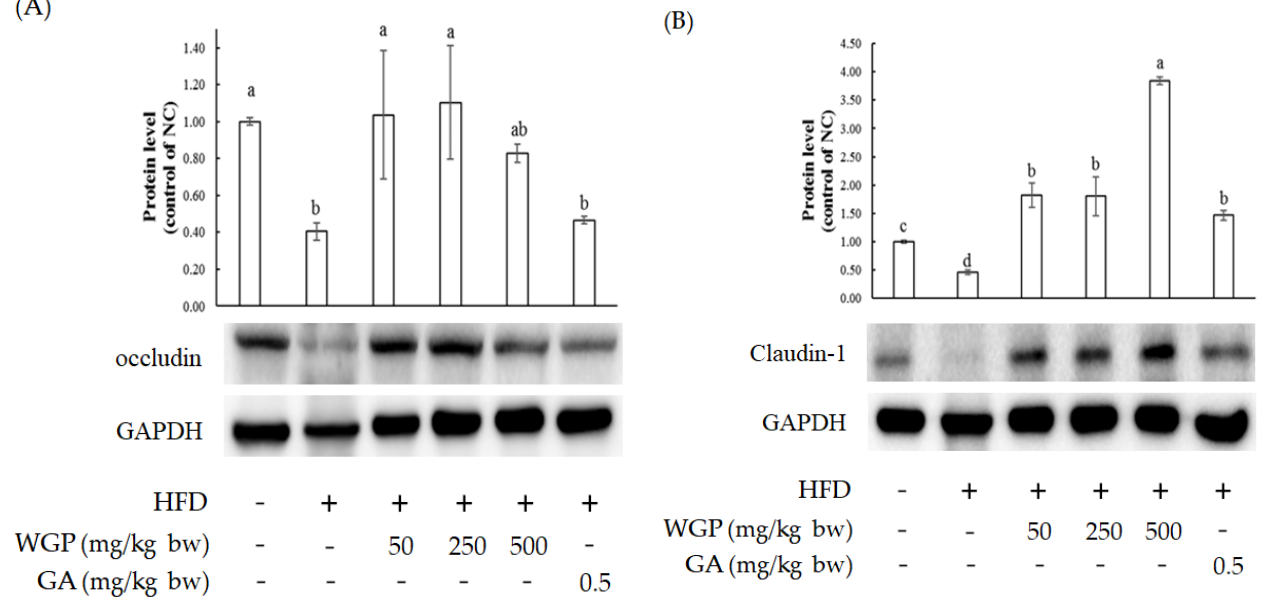
Figure 6. Effects of WGP on tight − junction proteins, including ( A ) occludin and ( B ) claudin − 1, in the large intestines of the HFD − induced C57BL/6 mice. The values are shown as the means ± SDs (n = 6). The di ff erent superscript le tt ers in the same column ( a–d ) denote signi fi cant di ff erences ( p < 0.05).